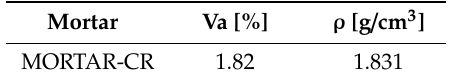
Table 8. Air voids content and density for MORTAR-CR.